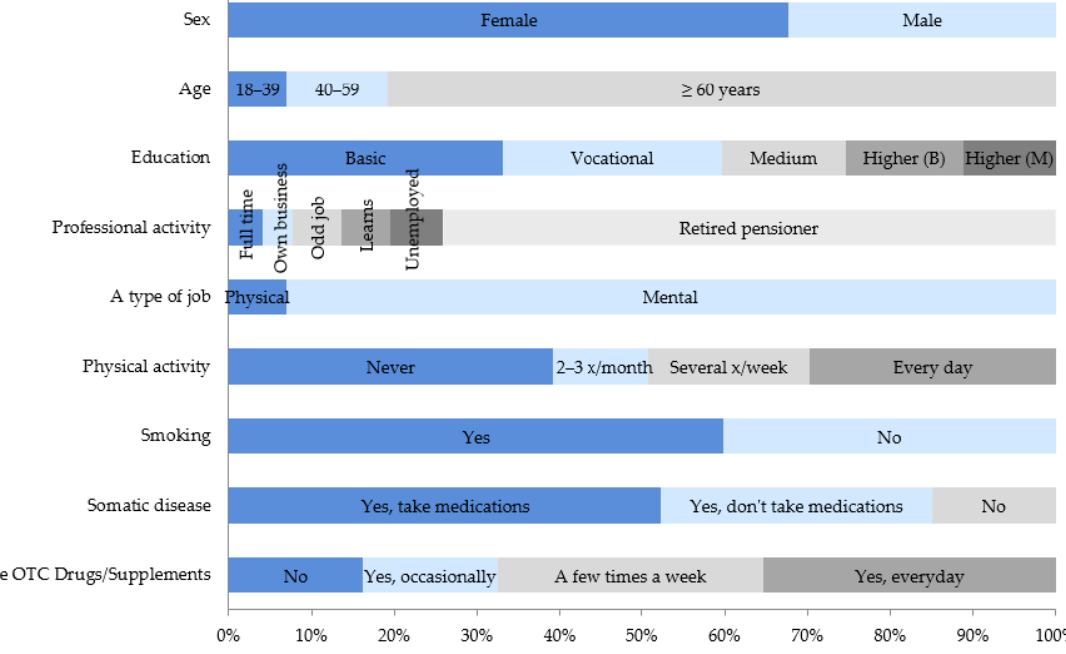
Figure 2. Factors modifying the risk of depressive disorders (HADS-D3) that were statistically significant.